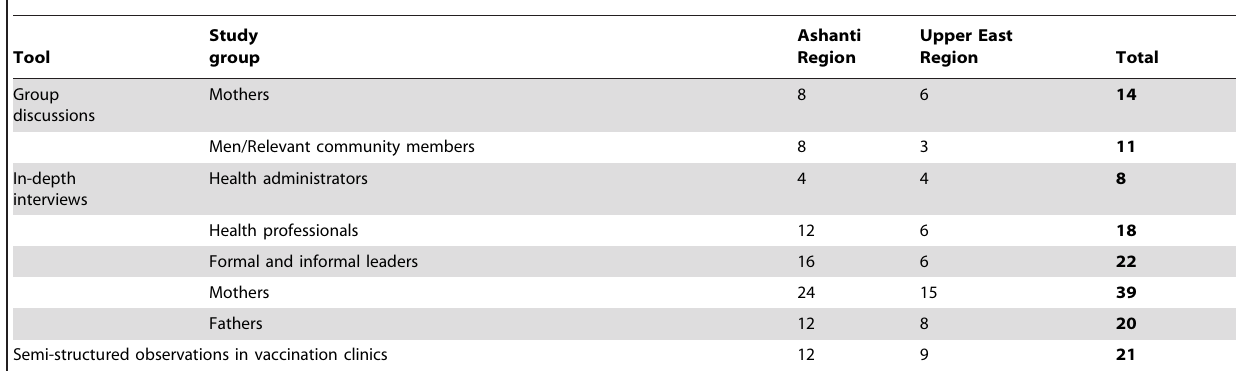
Table 2. Study groups and number of collection events.